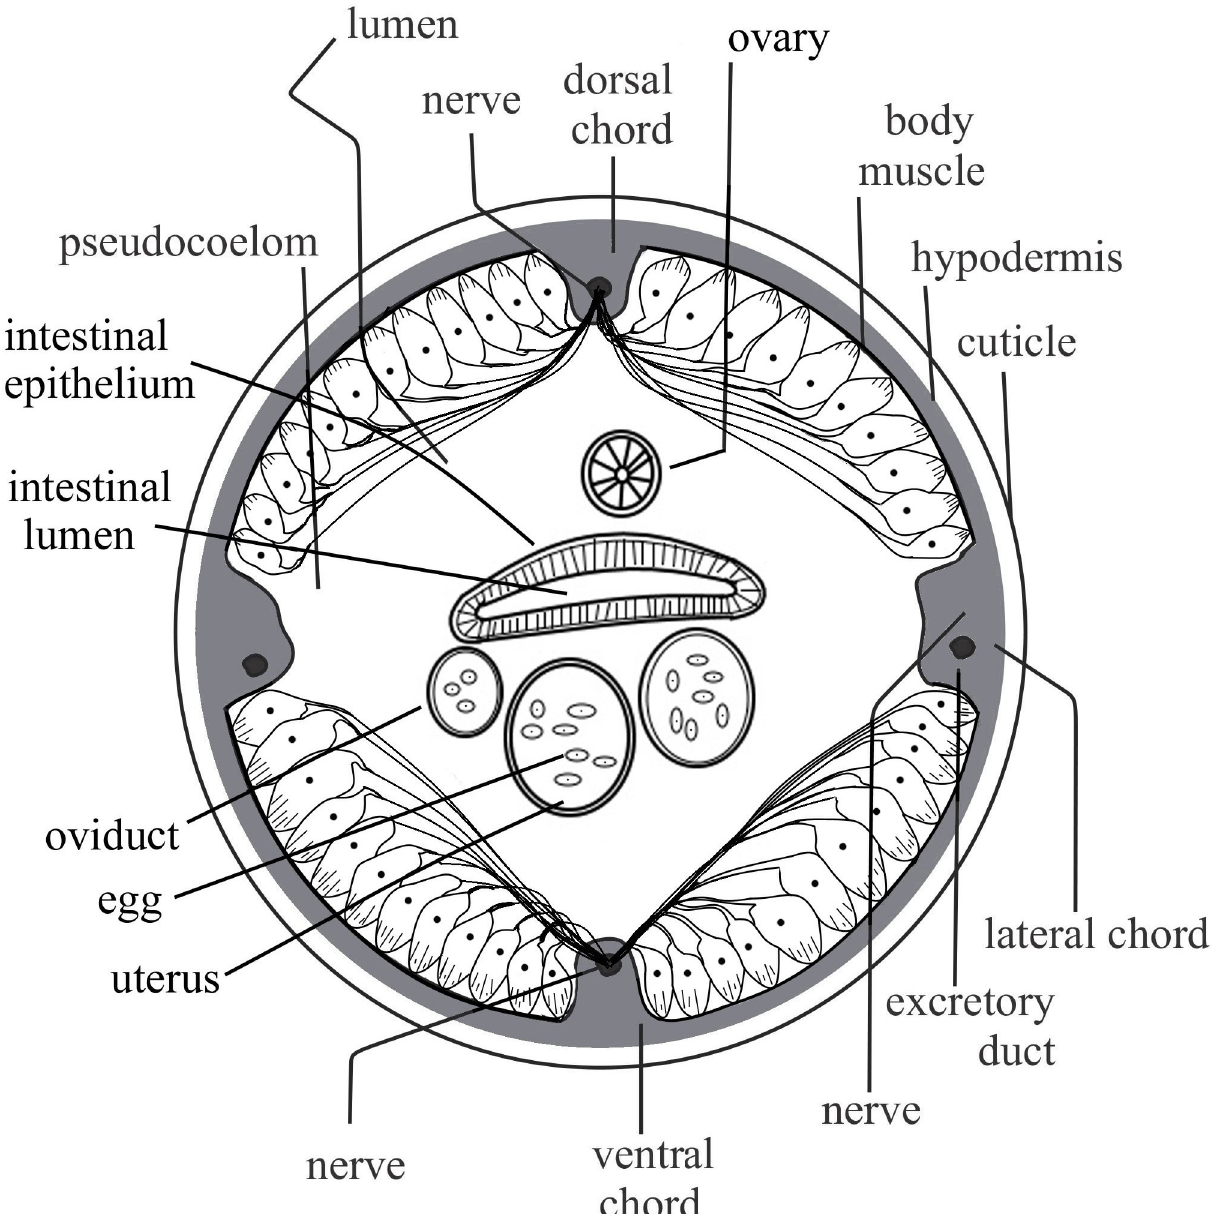
Fig 6. Cross-section of a nematode showing cuticle, muscles and internal organs in pseudocoelom cavity (Improved from Shokoohi, 2019). Due to the symmetric nature of the latero-dorsal and latero-ventral longitudinal somatic muscles, when the latero-dorsal muscles contract in a given region ( increase in muscle volume ), equivalent rows of the latero-ventral somatic muscles relax ( decrease in muscle volume ), results in the nematode body being bent towards the ventral side, vice versa . The simultaneous con- traction-relaxation of opposite longitudinal somatic muscles modulates potential excessive hydrostatic pressure in pseudocoelom cavity of nematode body (Fig 6). The simultaneous relaxation and contraction of longitudinal somatic muscles in opposite symmetries, results in nematode bodies bending towards the symmetry with relaxed muscles. In S . feltiae IJ, nictation